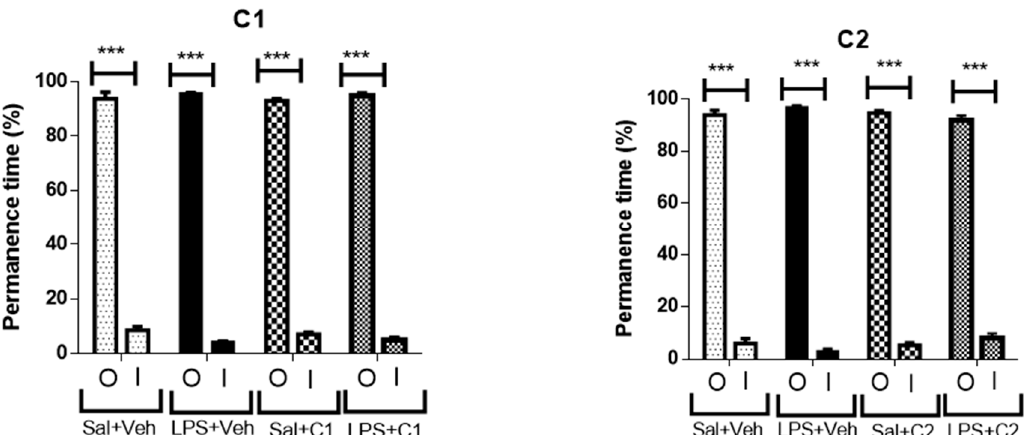
Figure 14. Effects of treatment in permanence time in the outside area (O) and inside area (I) in Open Field. Saline (sal), Vehicle (veh, vehicle used for the ligand dilution). *** p < 0.001 of inside area against outside area. Inside areas did not demonstrate to be statistically different among them.